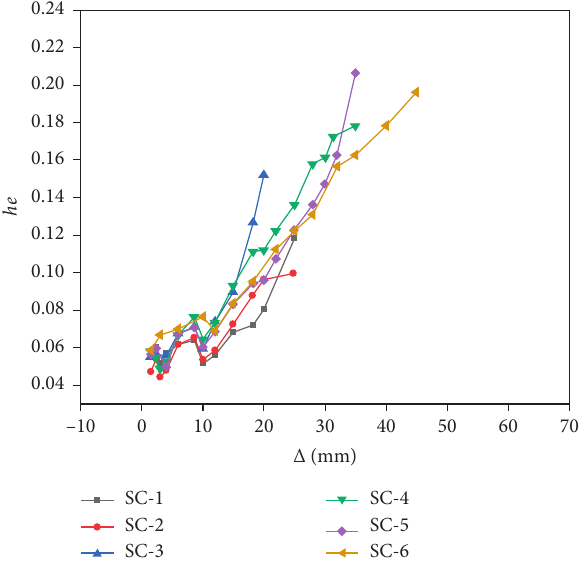
Figure 12: Viscous damping coefficient curves of each specimen. The equivalent viscous damping coefficient ( h e ) of the specimen and the displacement ( Δ ) curve of the column end were calculated for each Table 6: Accumulated dissipated energy ( E Specimen